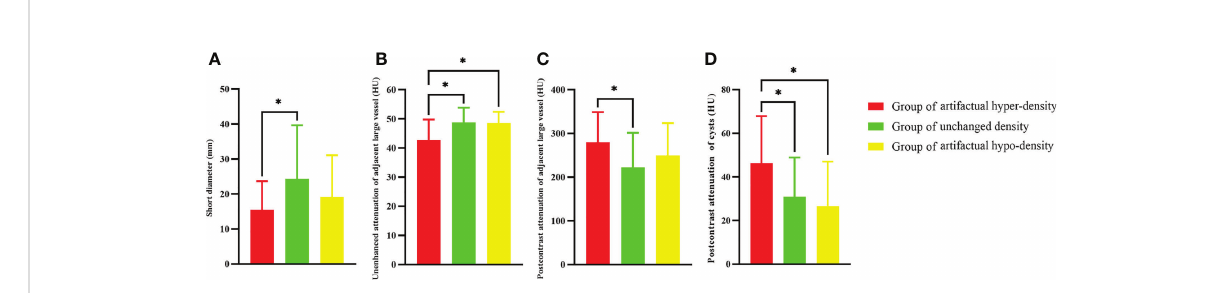
FIGURE 2 The group difference between the groups of artifactual hyper-density, unchanged density, and artifactual hypo-density according to the CT attenuation change of thymic cysts between contrast-enhanced and nonenhanced CT. (A) The group of > 5 HU had smaller short diameter (p=0.008), (B) lower nonenhanced attenuation values of adjacent large vessel than the group of -5~5 HU (p < 0.001) and the group of <-5 HU (p=0.001), (C) higher postcontrast attenuation values of adjacent large vessel than the group of -5~5 HU (p < 0.001), and (D) higher postcontrast attenuation values of cysts than the group of -5~5 HU (p < 0.001) and the group of <-5 HU (p < 0.001). * indicates signi fi cant